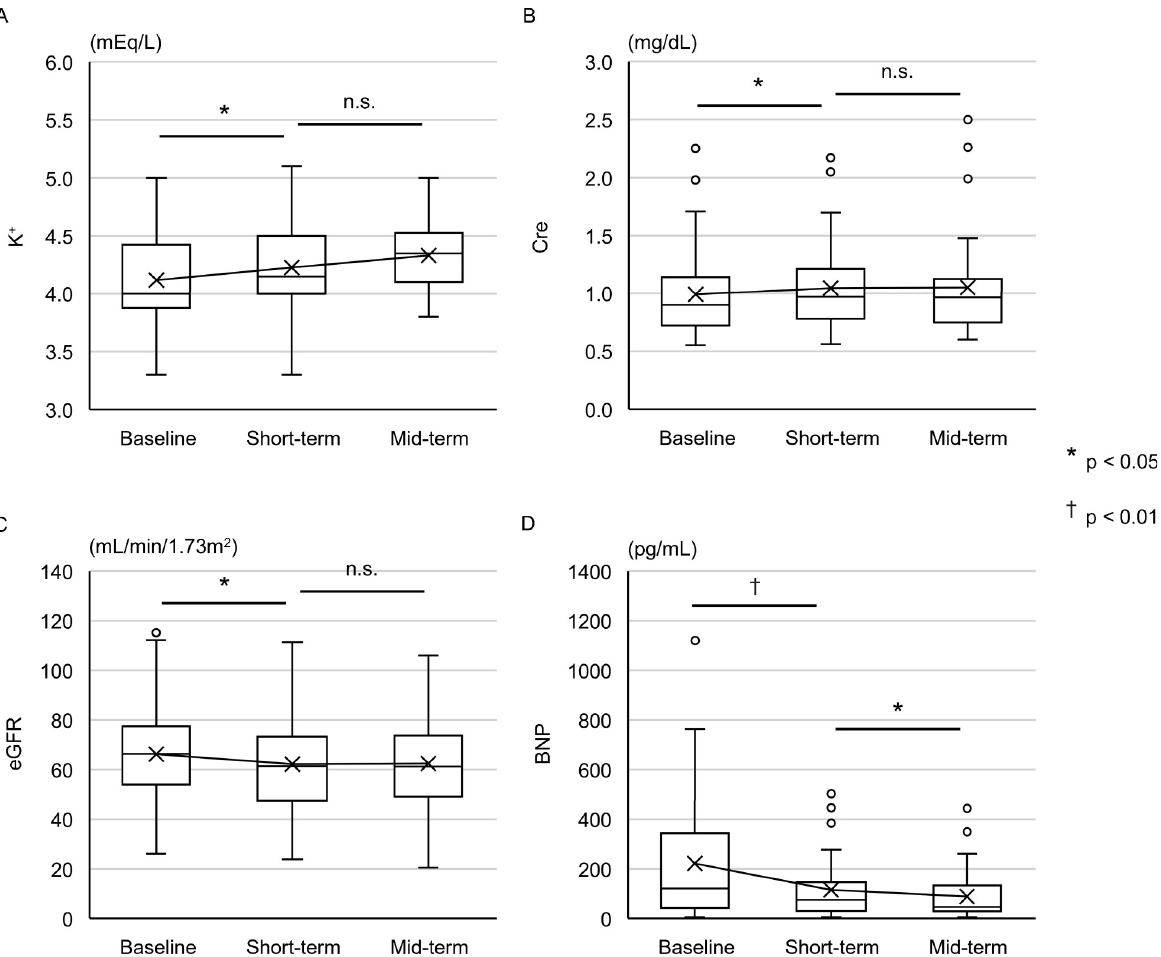
Fig 4. The mid-term assessment of 38 patients. Changes in K + (A), Cre (B), eGFR (C), and BNP (D) between baseline, short-term, and mid-term assessments for 38 patients with mid-term assessment data available. K + , Cre, eGFR were compared using the paired t-test, and BNP level was compared using the Wilcoxon signed-rank test. � : p < 0.05, and †: p < 0.01. K + , serum potassium; Cre, serum creatinine; eGFR, estimated glomerular filtration rate; BNP, brain natriuretic